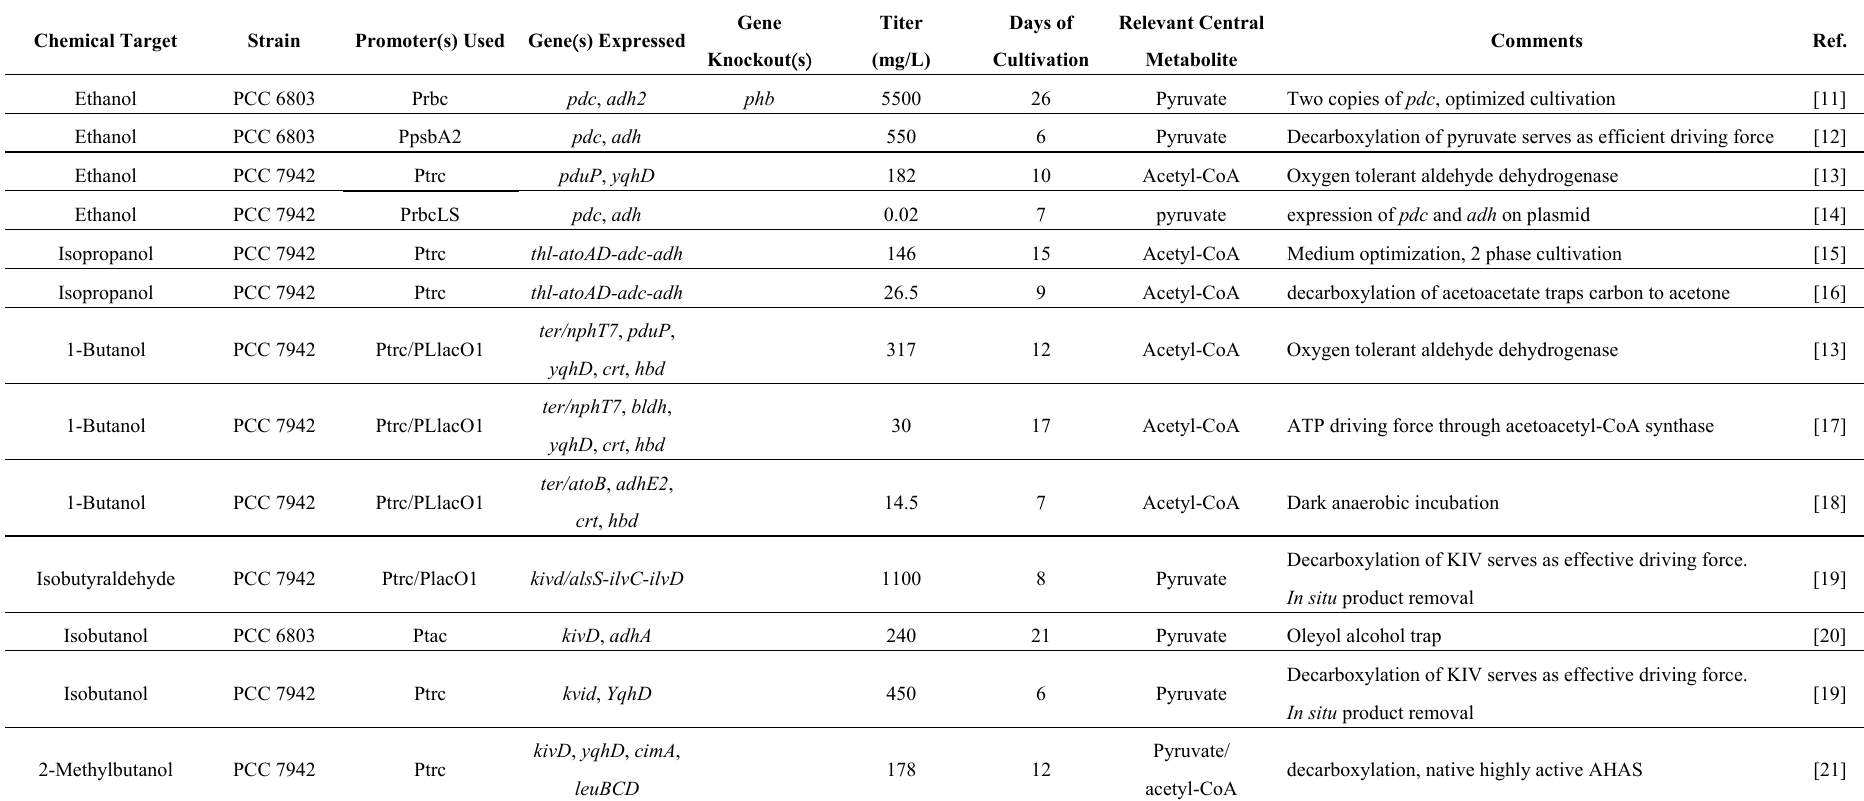
Table 2. Chemical targets, promoters used, genes expressed, titer, and relevant central